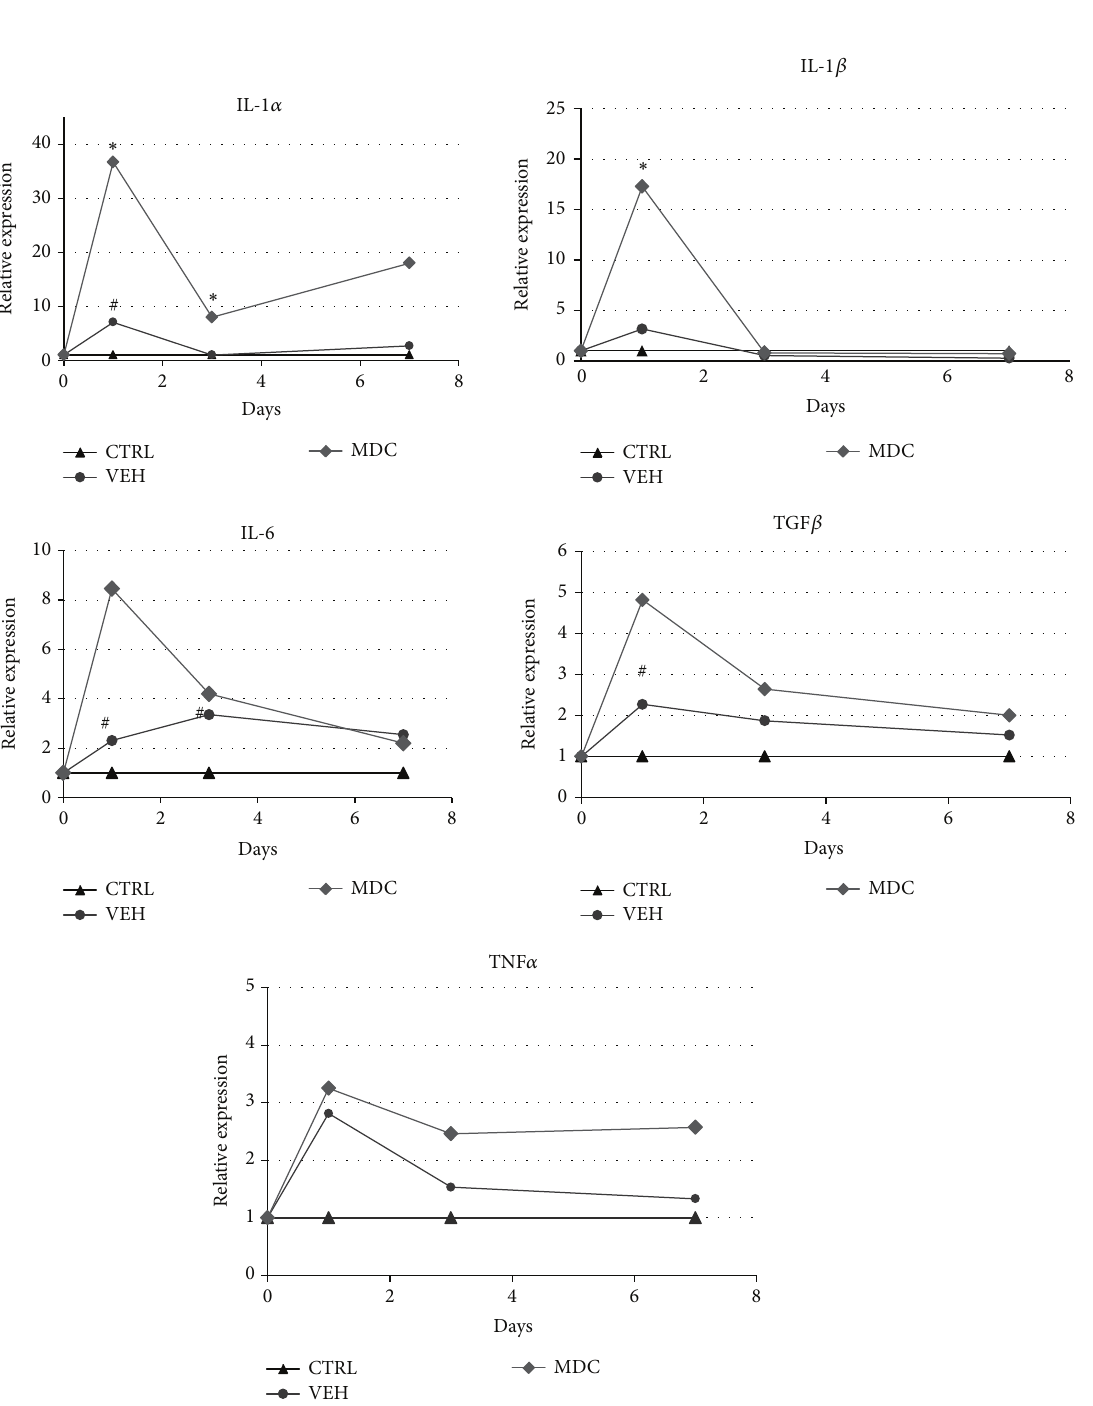
Figure 2: The analysis of cytokines gene expression in the muscle tissue determined by real-time PCR. The graphs represent relative gene expression of Il-1 𝛼 , Il-1 𝛽 , Il-6, Tgf- 𝛽 , and Tnf- 𝛼 in animals’ muscles from different groups: untreated control (CTRL), after vehicle injection (VEH), and after MDCs transplantation (MDC) 1, 3, and 7 days after surgery. Results were analyzed in pairs (untreated control versus VEH and VEH versus MDC) using nonparametric U Mann-Whitney test. ∗ indicates statistically significant difference between MDC and VEH groups and # indicates statistically significant difference between VEH and CTRL groups in certain time